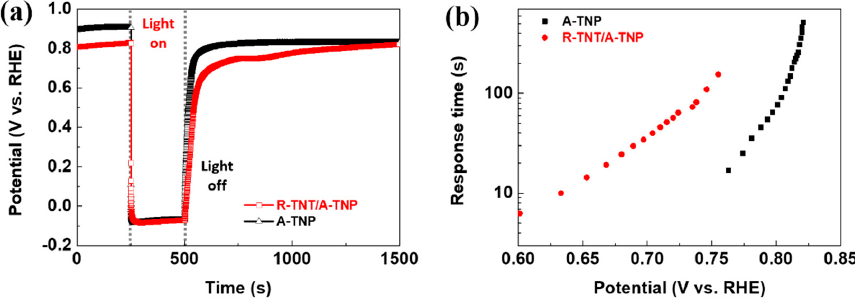
Figure 7. Charge transport properties of R-TNT / A-TNP and A-TNP: ( a ) Open-circuit potential vs. time profile of photoanodes; ( b ) electron response time vs. open-circuit potential plots of photoanodes.